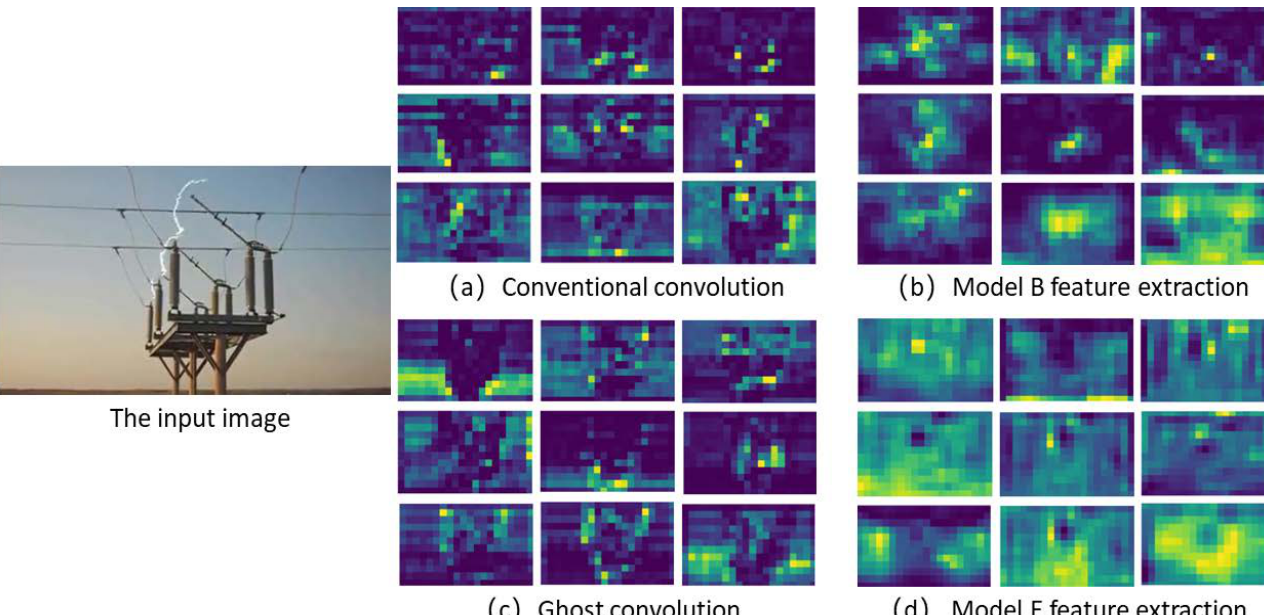
Figure 5. Comparison of feature extraction between the work in this paper and the original network structure. ( a ) Layer 7 feature extraction map after conventional convolution operation; ( b ) Model B network feature extraction structure display map; ( c ) Layer 7 feature extraction map after Ghost convolution operation; ( d ) feature extraction structure display diagram of Model E network.